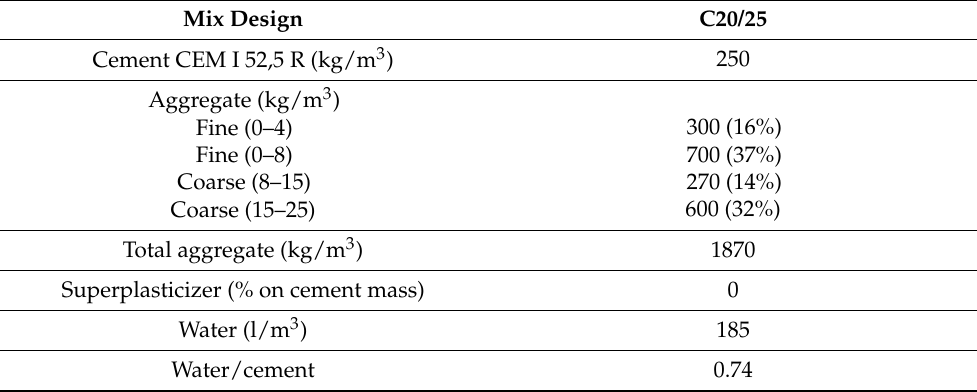
Table 2. Mixed components.